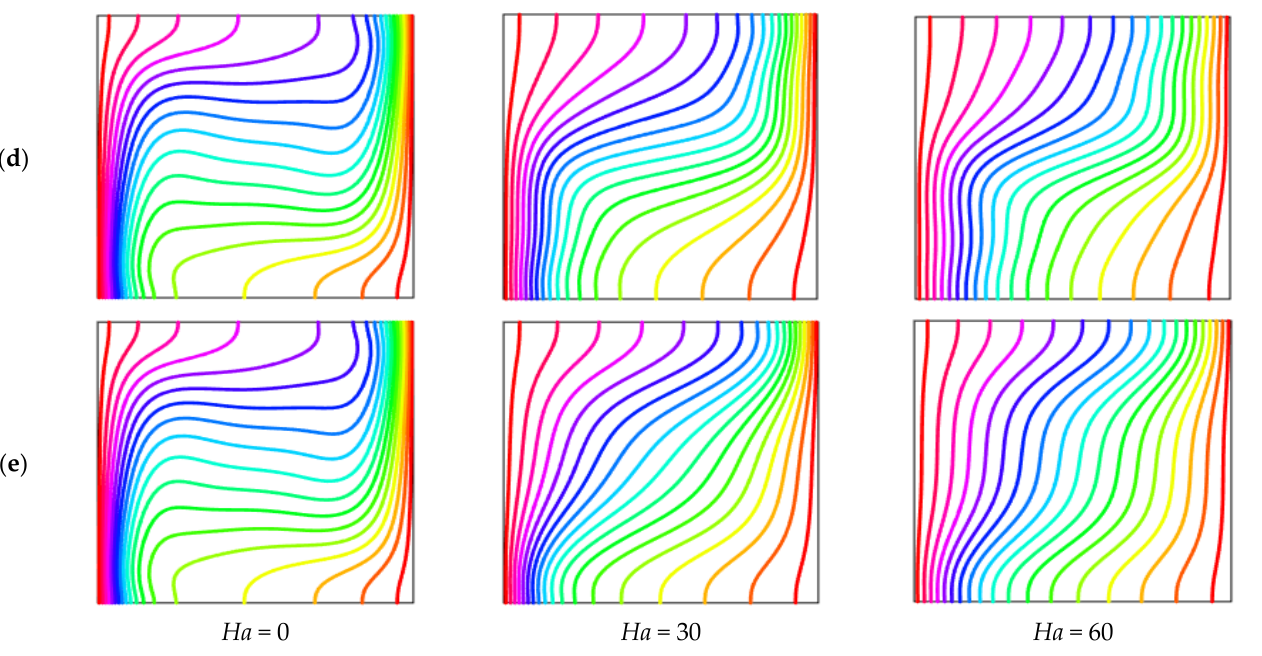
Figure 4. Effect of isotherms for various Hartmann number ( Ha ) for ( a ) uniform magnetic field (umf), ( b ) λ = 0.1, ( c ) λ = 0.25, ( d ) λ = 0.5, and ( e ) λ = 1 when Ra = 10 6 , d = 10 nm, ϕ = 0.04, n = 3, Pr = 6.8377, and τ = 1.